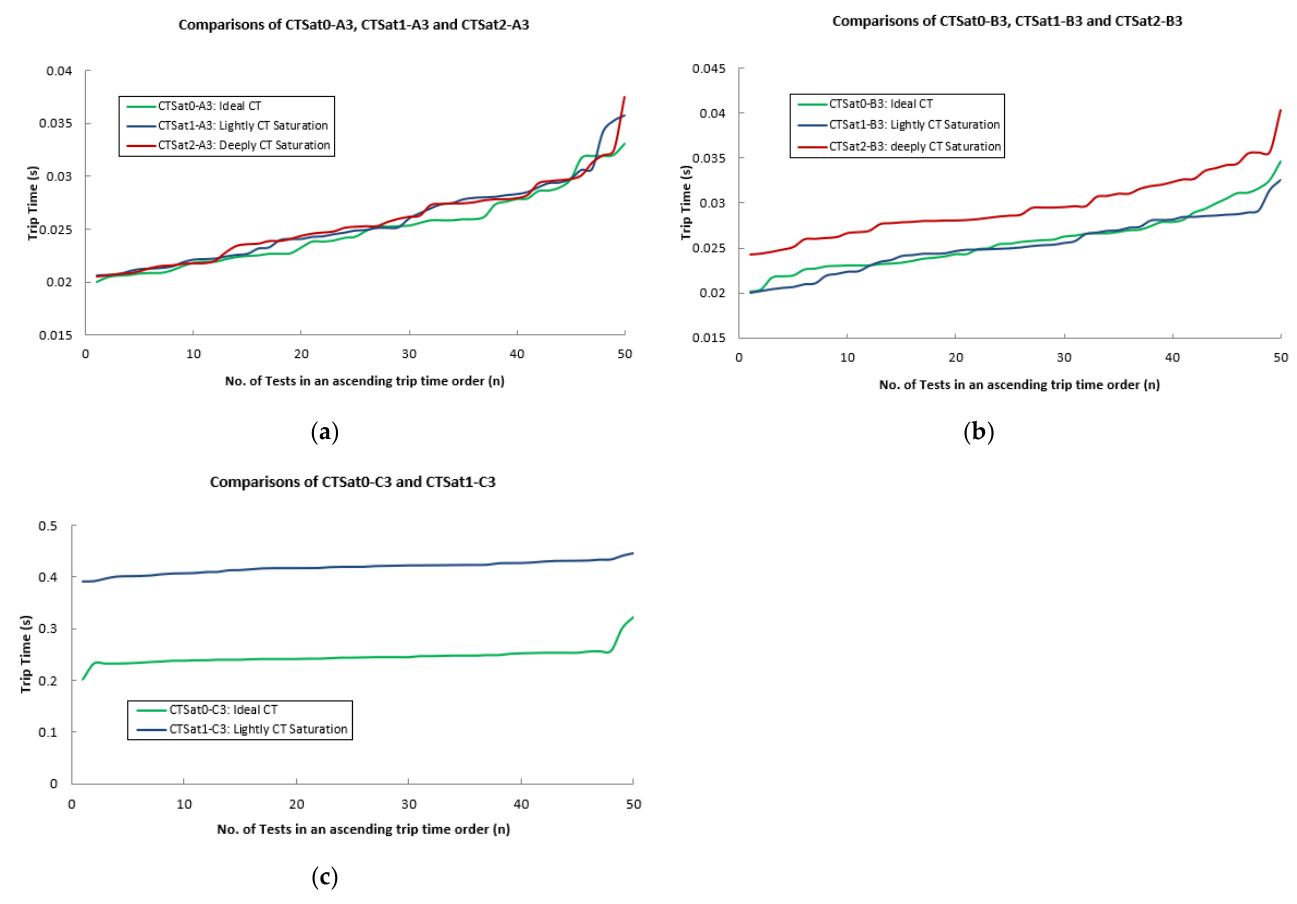
Figure 23. Comparisons: ( a ) CTSat0-A3, CTSat1-A3 and CTSat2-A3 (situations with different levels of CT, no faulty component, L-L-G fault at 100% of the feeder); ( b ) CTSat0-B3, CTSat1-B3 and CTSat2-B3 (situations with different levels of CT, 1 faulty fibre, L-L-G fault at 100% of the feeder); and ( c ) CTSat0-C3 and CTSat1-C3 (situations with different levels of CT, 1 faulty AMU, L-L-G fault at 100% of the feeder).